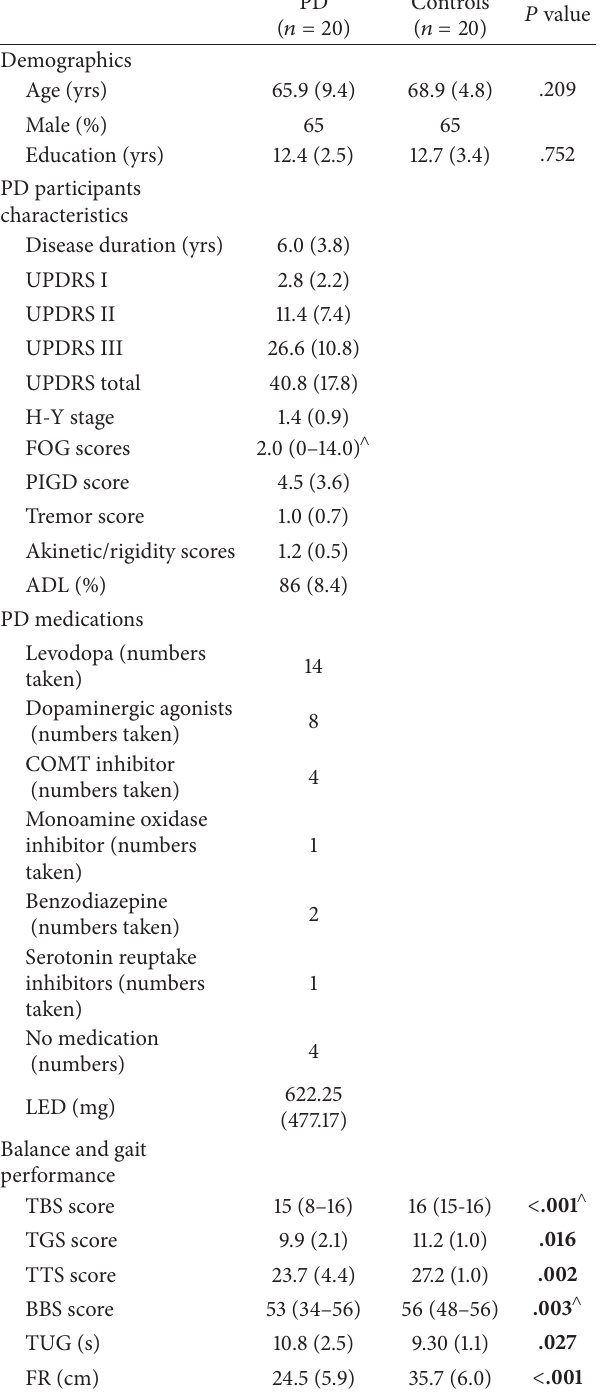
Table 1: Demographic characteristics of PD and control